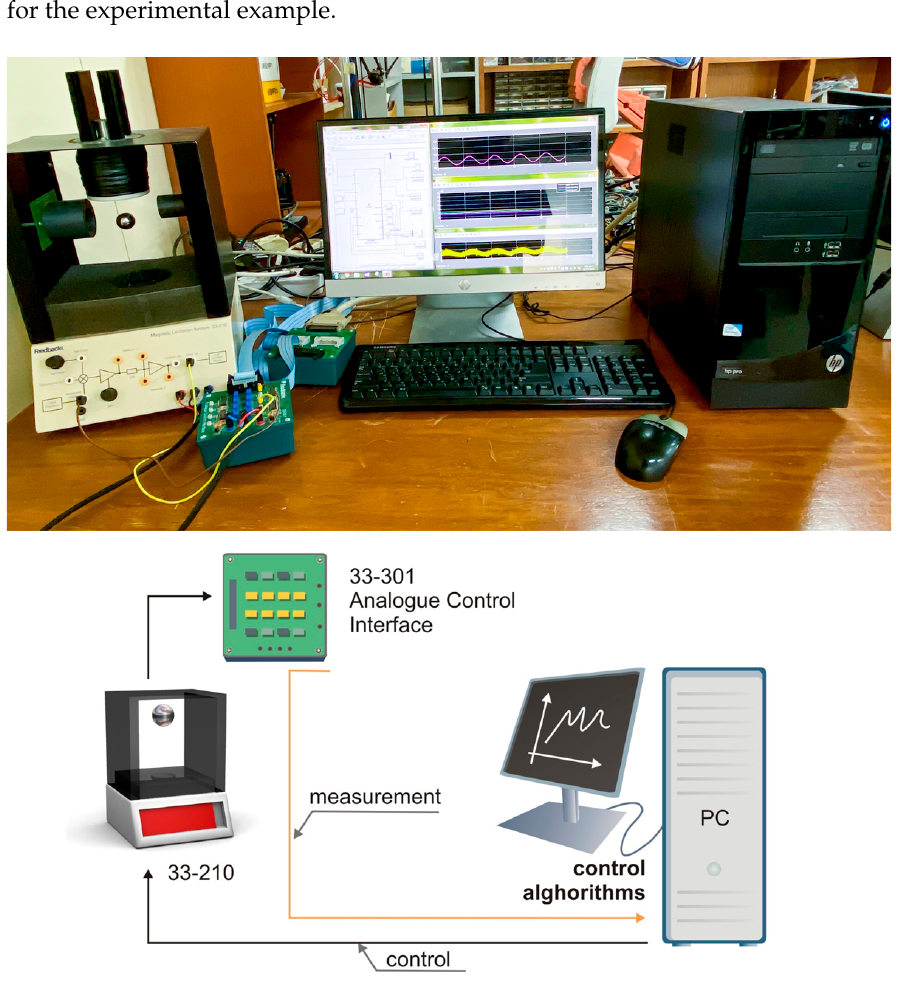
Figure 10. Configuration of experimental